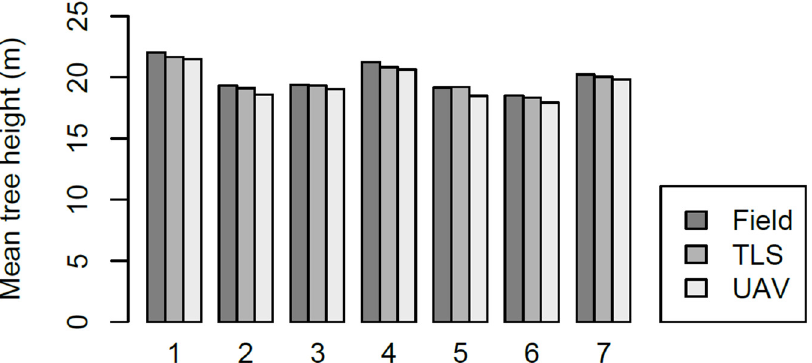
Figure 8. Mean tree heights within different thinning treatments measured in the field and with terrestrial laser scanning (TLS) and unmanned aerial vehicle (UAV). Treatment numbers are explained in Table 2. Table 11. Mean tree heights (with standard deviations, ±) measured in the field and with terrestrial laser scanning (TLS) and unmanned aerial vehicle (UAV), and mean difference and root mean square error (RMSE) compared to the field measurements. Mean Tree Height (m) Mean Difference (m) RMSE (m)